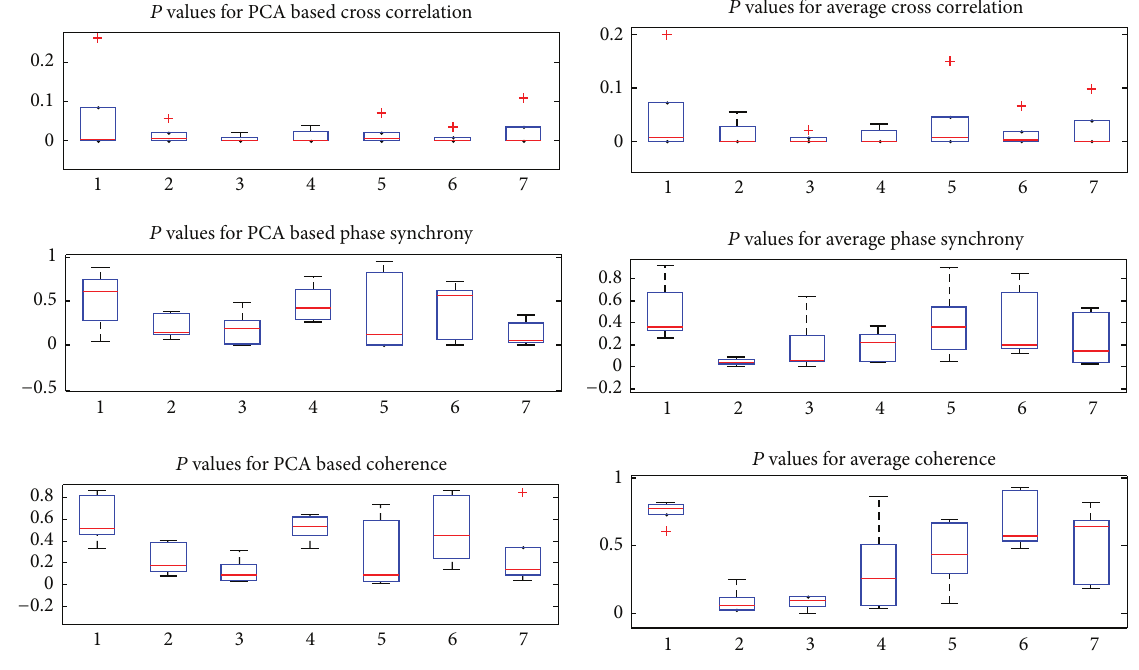
Figure 4: Boxplots show the results of three synchrony measures for PCA and Average methods.